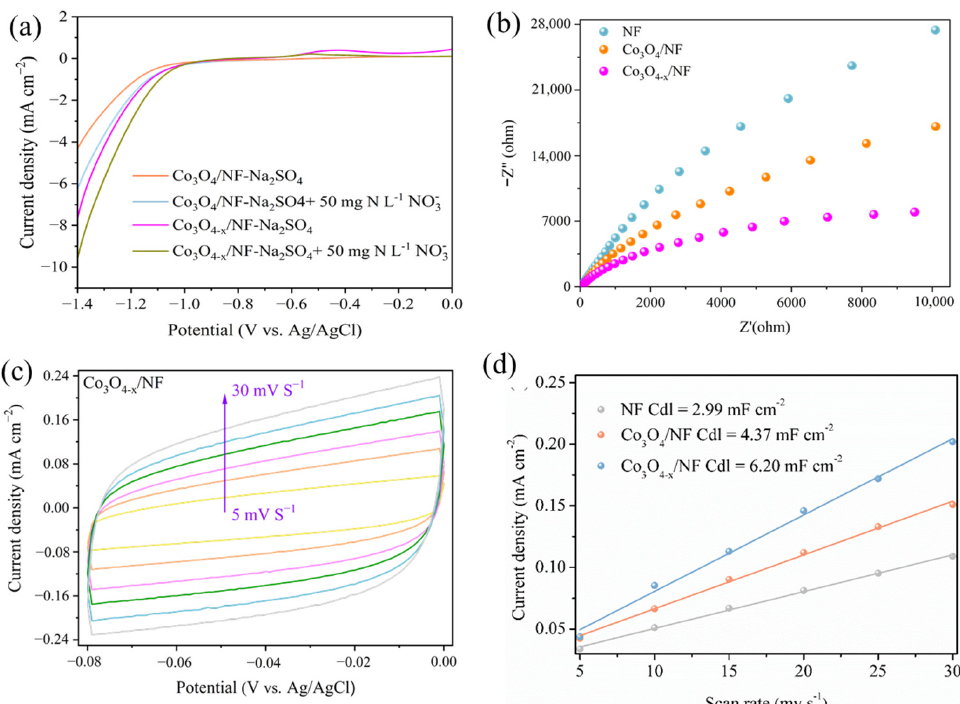
Metals 2023 , 13 , 799 Figure 3. LSV curves of Co 3 O 4 /NF and Co 3 O 4-x /NF tested with and without NO 3 − -N ( a ); EIS spectra Figure 3. LSV curves of Co 3 O 4 /NF and Co 3 O 4 − x /NF tested with and without NO 3 − -N ( a ); EIS of di ff erent electrodes ( b ); CV curves of Co 3 O 4-x /NF ( c ) in the range of − 0.06~0.06 V vs. Ag/AgCl; and spectra of different electrodes ( b ); CV curves of Co 3 O 4 − x /NF ( c ) in the range of − 0.06~0.06 V vs. linear fi tt ing of the capacitive properties of current density vs. scan rate ( d ). Ag/AgCl; and linear fitting of the capacitive properties of current density vs. scan rate ( d ).